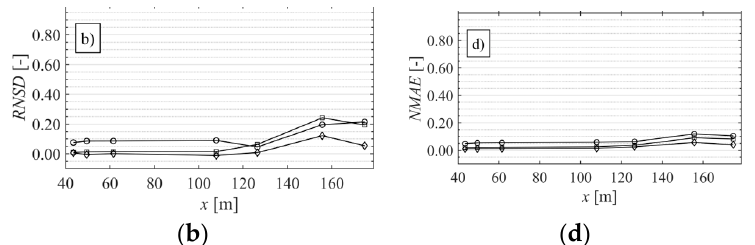
Figure A1. OF model grid resolution convergence analysis of the η time series at the WG locations along the flume up to the dike toe (WG14) based on ( a ) the normalised bias, ( b ) the residual normalised standard deviation, ( c ) the residual correlation coefficient, and ( d ) the normalised mean-absolute-error. The reference is the finest mesh with a refinement level in the surface elevation zones β sez of 3.